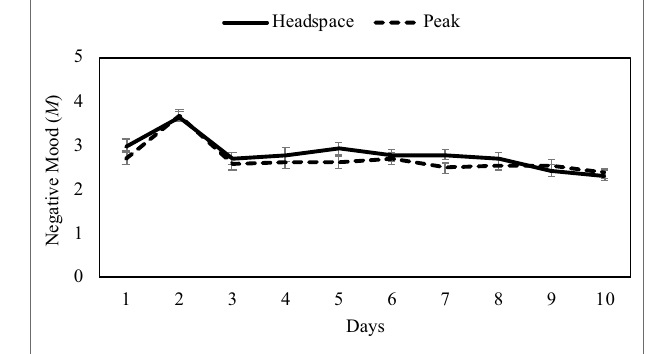
FIGURE 4 | Mean negative mood scores by intervention day and condition, with ±1 standard error